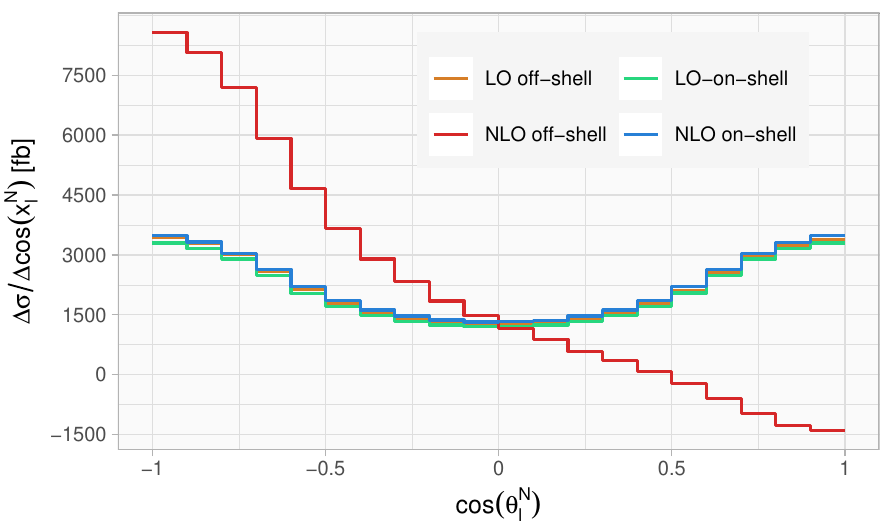
Figure 8. Angular distribution cos (cid:18) N at LO and NLO for an on-shell and o(cid:11)-shell top quark. l The NLO o(cid:11)-shell result becomes unphysical and indicates a strong sensitivity to the cancellation of soft